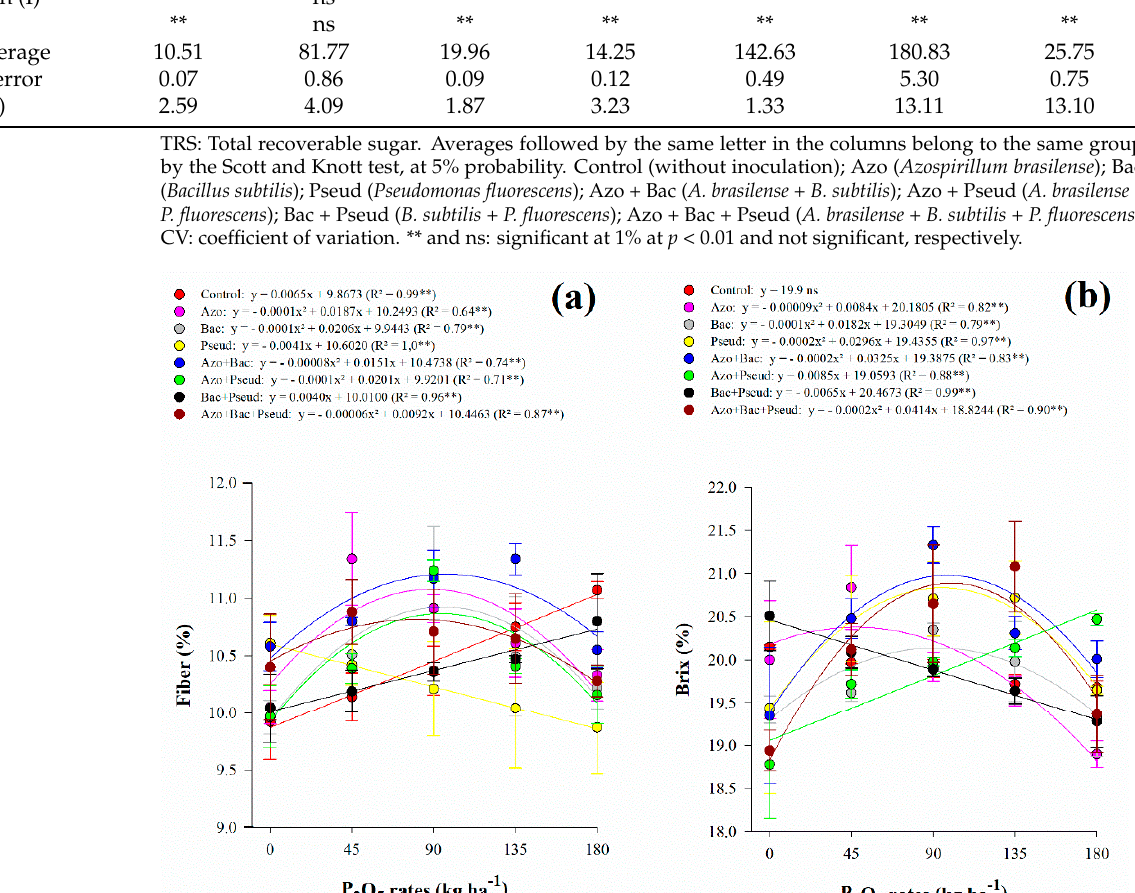
Figure 2. Interaction between P 2 O 5 rates and inoculations for fiber ( a ), soluble solids content (Brix) ( b ) and apparent sucrose of juice (Pol) ( c ) content of sugarcane. Error bars indicate the standard deviation of the mean ( n = 3). **, * and ns: significant at 1% at p < 0.01, 5% at p < 0.05 and p > 0.01 and not significant, respectively.